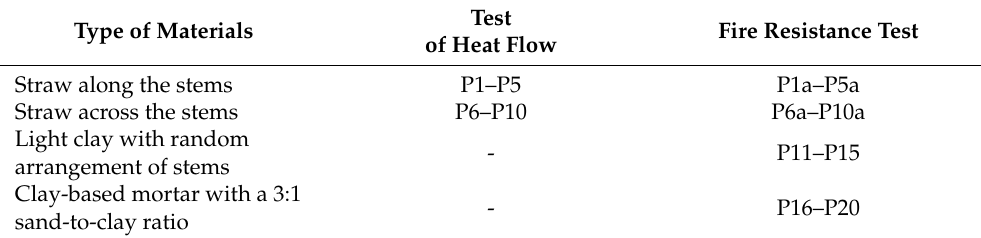
Table 1. The list of tests performed and the number of tested samples.